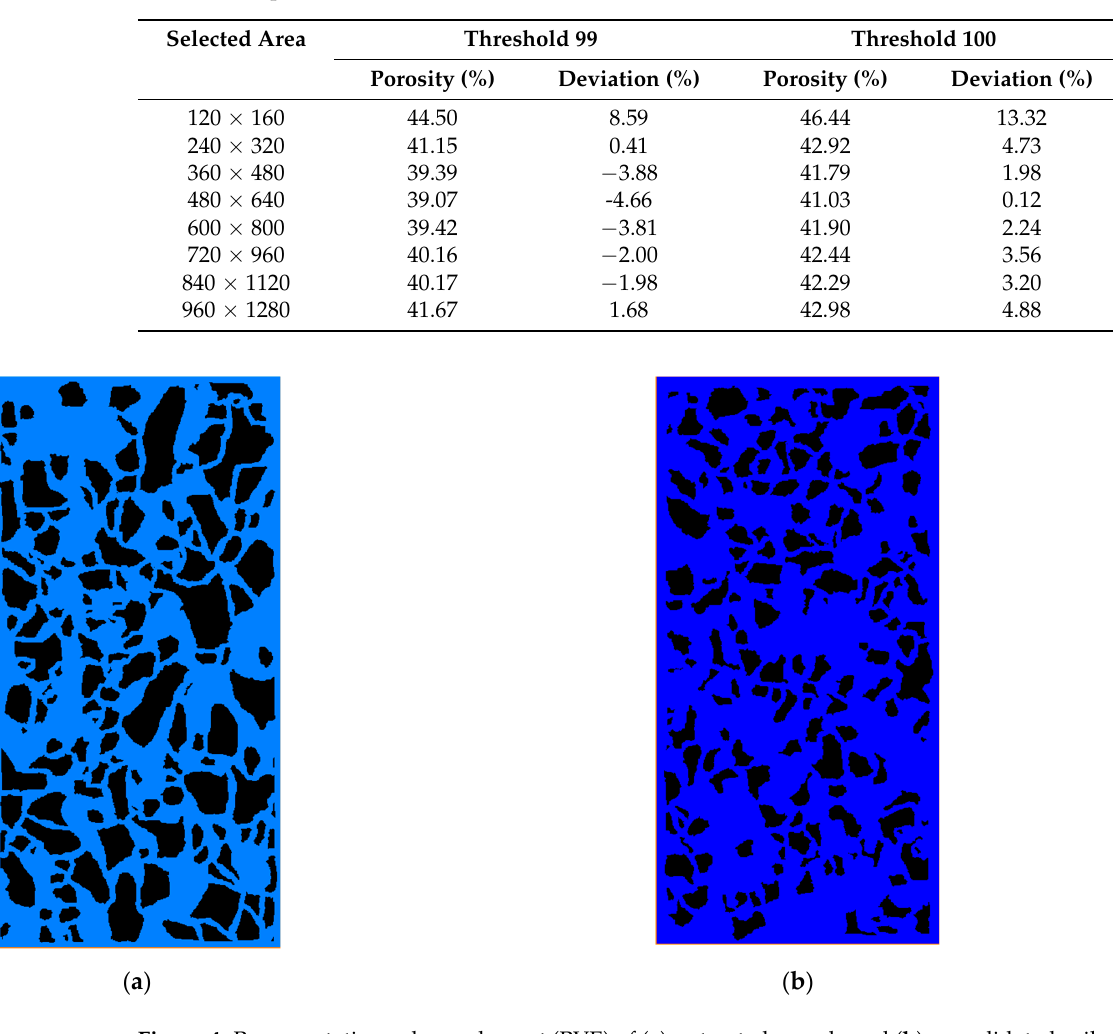
Table 1. Comparison of different thresholds and selected areas.